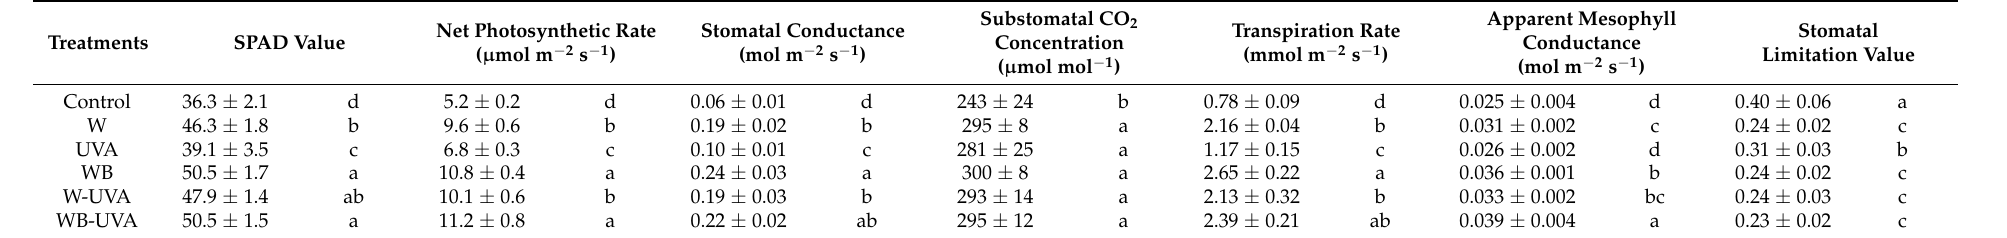
Table 2. Photosynthetic characteristics of cucumber seedlings cultivated in the greenhouse under supplementary light provided by white (W), UV-A light-emitting diodes (LEDs), and various combinations of W, blue (B), and UV-A LEDs; cucumber seedlings cultivated without supplementary light were used as control.